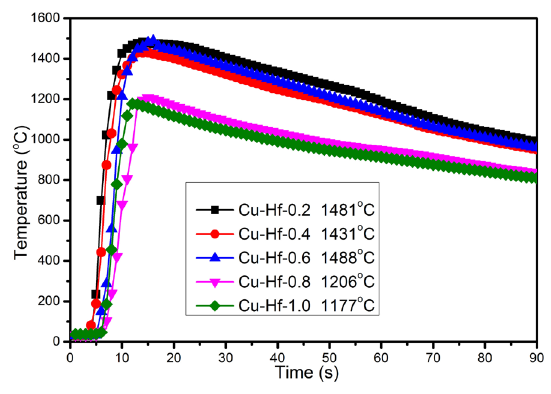
Fig. 2 Combustion temperature of the Hf-doped samples.